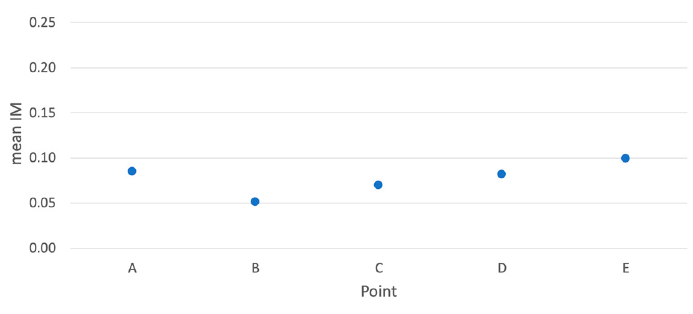
Figure 13. Mean IM calculated for each measurement point on the lower deck.